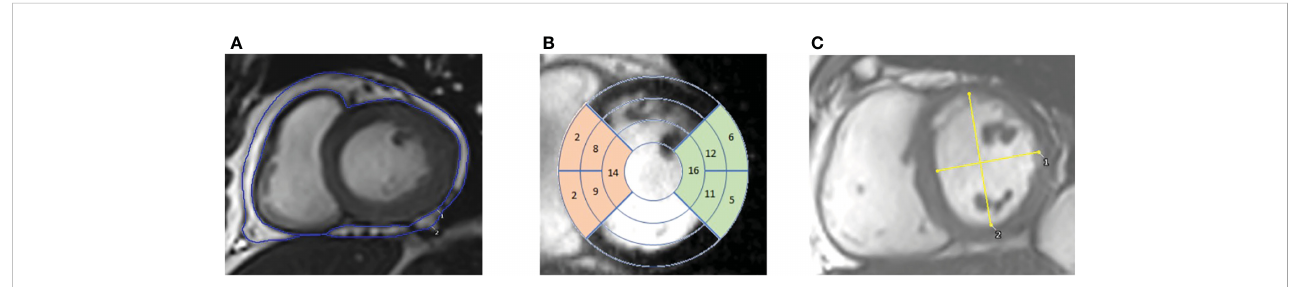
FIGURE 1 CMR images. (A) – contouring of epicardial adipose tissue in the short axis view. (B) – 17 segment view overlayed on short axis images. Highlighting the septal segments (in orange) and the lateral segments (in green). (C) – Short axis view with measurements of the maximal anterior-posterior (AP) diameter parallel to the septum and maximal septal-lateral (SL) diameter orthogonal to the AP diameter, with left ventricular eccentricity index being calculated by diving AP/SL